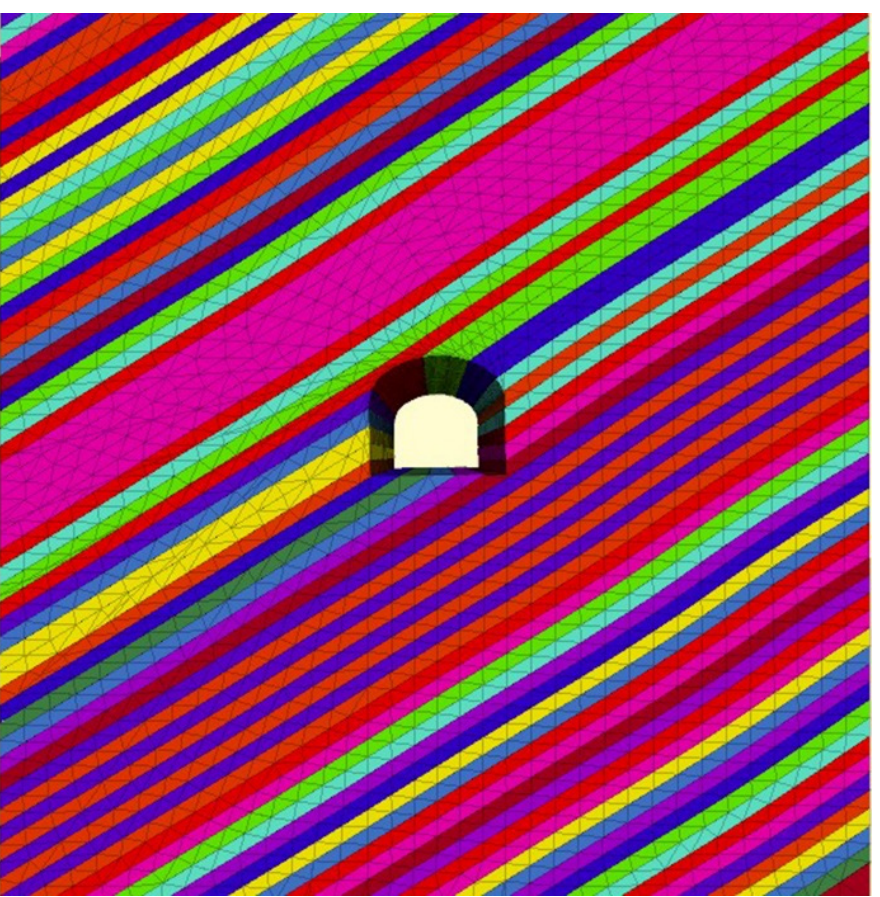
Figure 9. The calculation model.